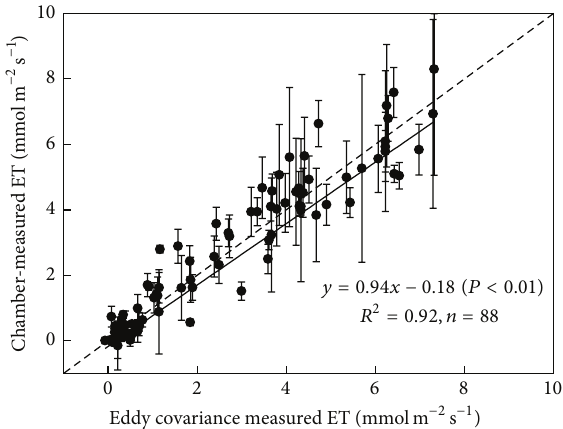
Figure 8: Comparison of the ecosystem vapor exchange (ET) obtained by the chamber method and the eddy covariance system. Data were obtained from the eddy covariance system located in the center of grazed grassland